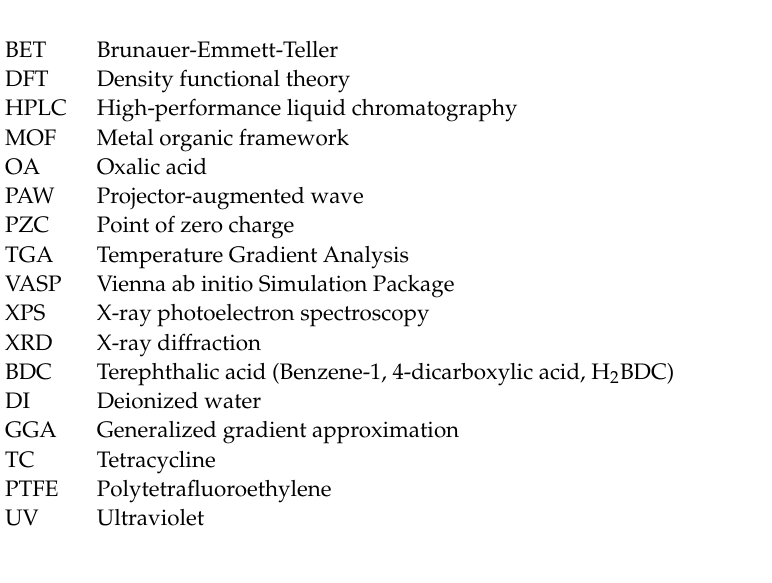
Figure S2: Photographs of (a) UiO-66 and (b) UiO-66-NH 2 powders, Figure S3: FE-SEM images of UiO-66 (a) before and (b) after adsorption, and UiO-66-NH 2 (c) before and (d) after adsorption, Figure S4: Adsorption capacity of TCs by UiO-66 and UiO-66-NH 2 , Figure S5: Effect of pH on the adsorption capacity of TCs, Figure S6: Effect of different initial TC concentrations on (a) UiO-66 and (b) UiO-66-NH 2 , Figure S7: Comparison of the effect of ionic strength on TC adsorption at low initial concentration condition, Figure S8: Adsorption kinetics corresponding to the pseudo-first- and pseudo-second-order models of TCs on (a) UiO-66 and (b) UiO-66-NH 2 at different pH values, Figure S9: Adsorption isotherms corresponding to the Langmuir and Freundlich models of TCs on (a) UiO-66 and (b) UiO-66-NH 2 , Figure S10: Particle size distribution of